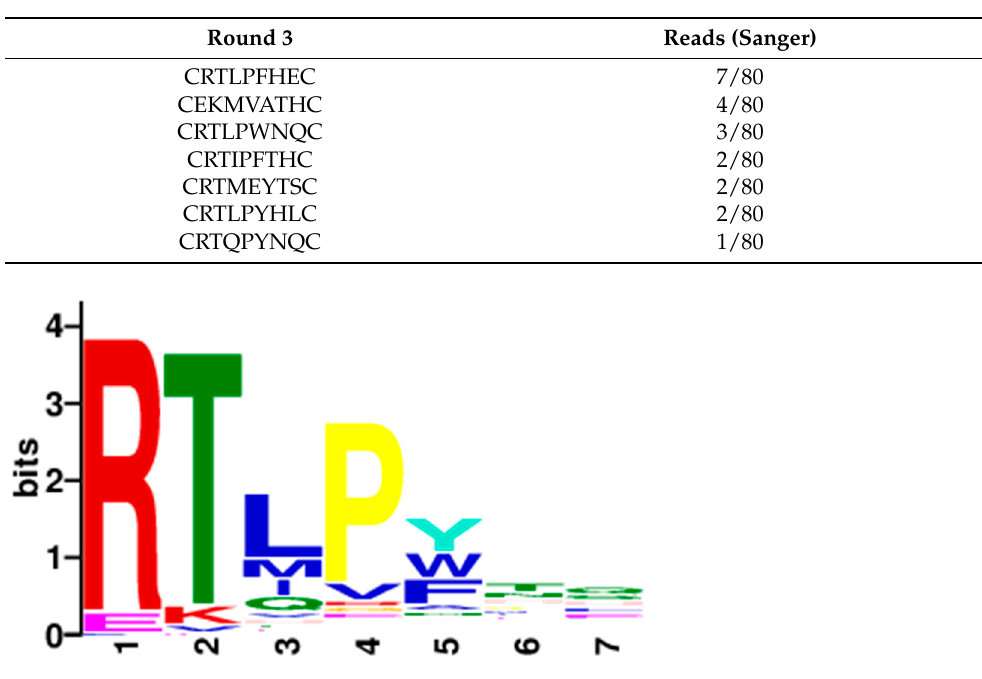
Figure 1. Random sequence comparison of the phage clone sequencing results of the third biopan- ning.